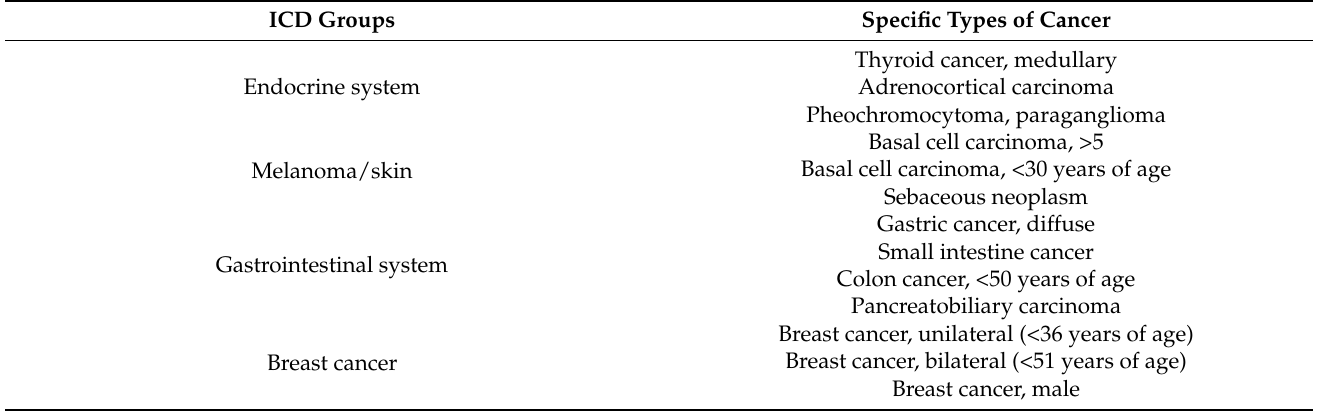
Table 1. Types of cancer associated with CPS used as indicator for need of referral to genetic counselling. ICD